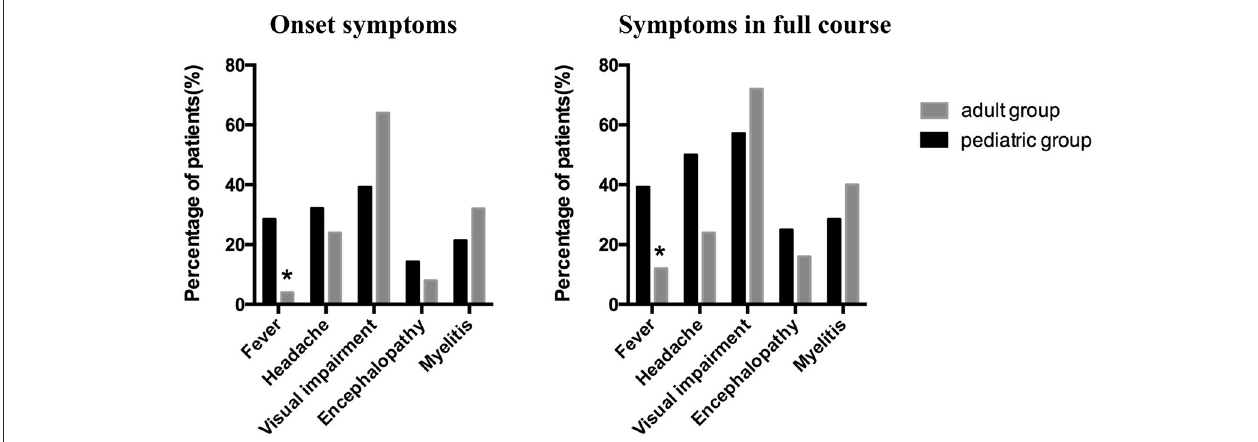
FIGURE 2 | The clinical symptoms at the onset and throughout the full course of the disease in the pediatric and adult patients. Visual impairment, headache, and fever were the top three common symptoms in the pediatric group, whereas visual impairment, myelitis symptoms, and headache were the top three common symptoms in the adult group. More pediatric than adult patients suffered from fever at initial onset ( p = 0.0442) and throughout the full course of the disease ( p = 0.0245).